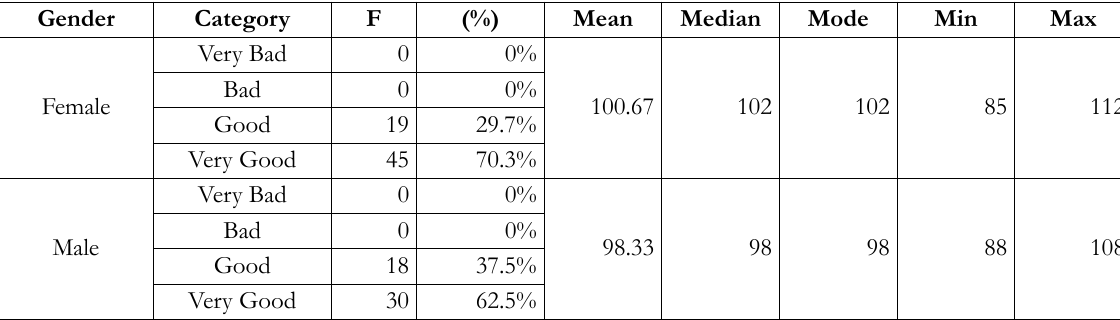
Table 5. Seventh Grade Student’s Perception of the Use of Web-based Character Assessment